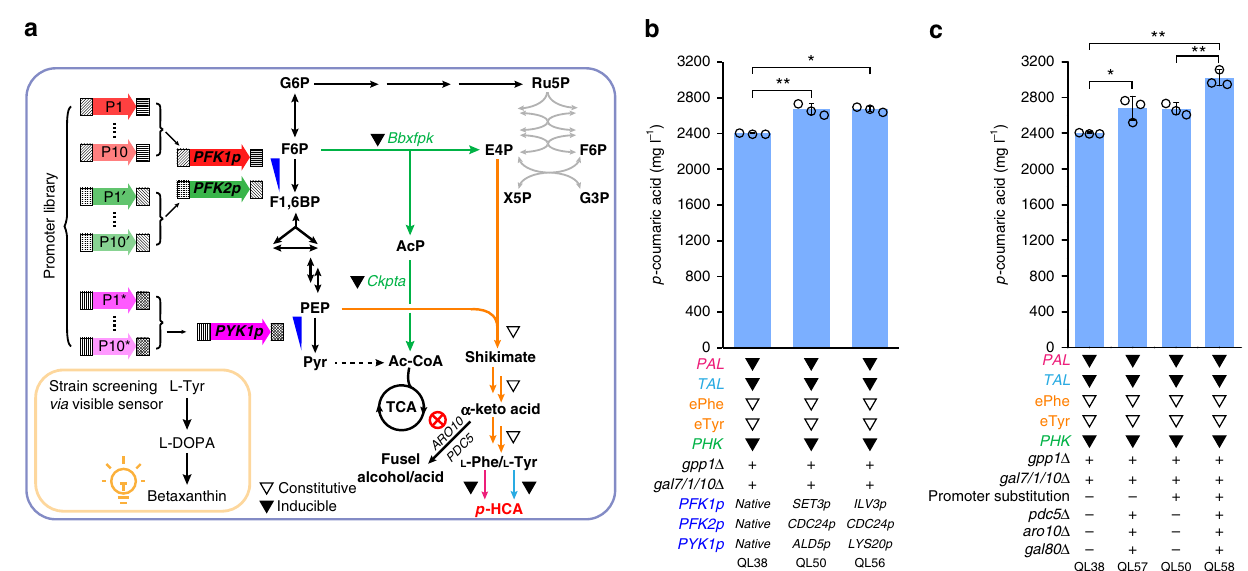
Fig. 5 Optimization of carbon distribution increases p -HCA production. a Schematic illustration of carbon redistribution between glycolysis and the AAA biosynthesis pathway through a promoter library screening approach. A promoter library was created to replace the original promoters of PFK1 , PFK2 , and PYK1 , which encode phosphofructokinase and pyruvate kinase, respectively, at key nodes between glycolysis and the AAA biosynthesis pathway. This promoter library was transformed into a yeast strain harboring the PHK pathway alongside the upregulated shikimate pathway, with the resulting strain screened by using a L -Tyr-derived pathway that indicated increased tyrosine production via the formation of the yellow pigment betaxanthin. Selected promoters exhibiting enhanced color intensity are listed in Supplementary Table 2. Furthermore, AAA degradation pathway was eliminated by deleting the corresponding genes (marked with a red cross) in the fi nal strains. Open triangles indicate the use of constitutive strong promoters for controlling gene expression, while fi lled triangles indicate the use of galactose-inducible promoters. b Simultaneous optimization of the promoters of PFK1 , PFK2 , and PYK1 improves p -HCA production. c Removing the AAA degradation pathway further enhances p -HCA titers. Deletion of GAL80 was additionally introduced to enable the induction of GAL promoters without the addition of galactose. For shake- fl ask cultivation, cells were grown in de fi ned minimal medium with six tablets of FeedBeads as the sole carbon source and 1% galactose as the inducer when required. For strains with the deletion of GAL80 , no galactose was supplemented. Cultures were sampled after 96 h of growth for p -HCA detection. Statistical analysis was performed by using Student ’ s t test (one-tailed; two-sample unequal variance; * p < 0.05, ** p < 0.01, *** p < 0.001). All data represent the mean of n = 3 biologically independent samples and error bars show standard deviation. The source data underlying fi gures b and c are provided in a Source Data fi